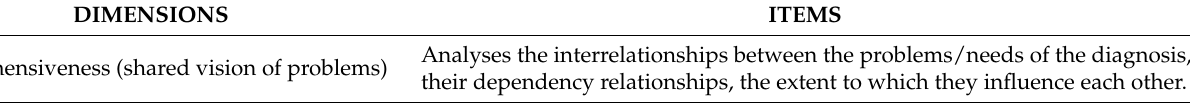
Table 2. Dimensions and items to measure integrality in integrated strategy